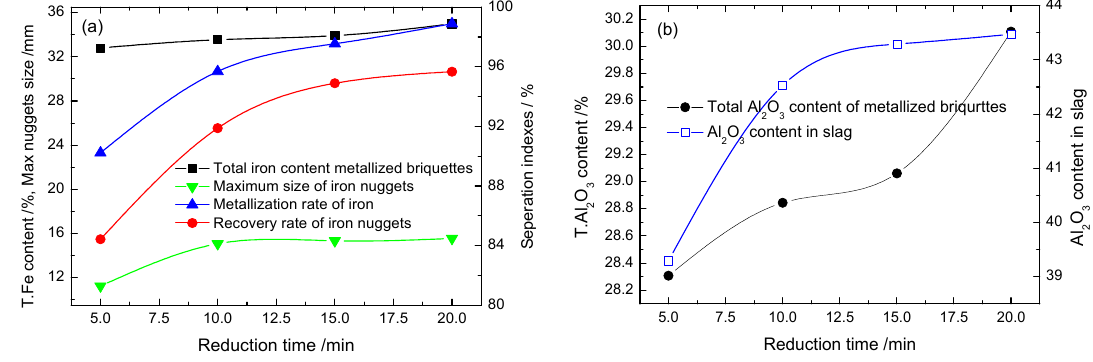
Figure 8. Effect of reduction time on the ( a ) reduction indexes and ( b ) Al 2 O 3 grade.